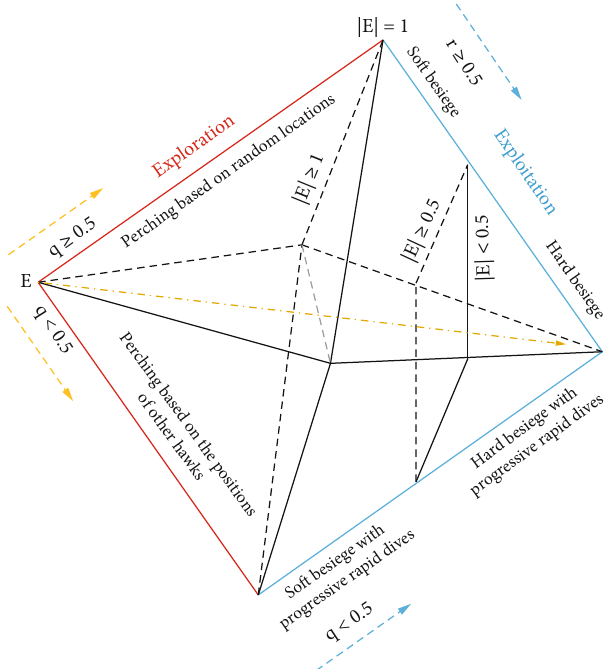
Figure 3: Di ff erent phases of the Harris Hawk Optimization.